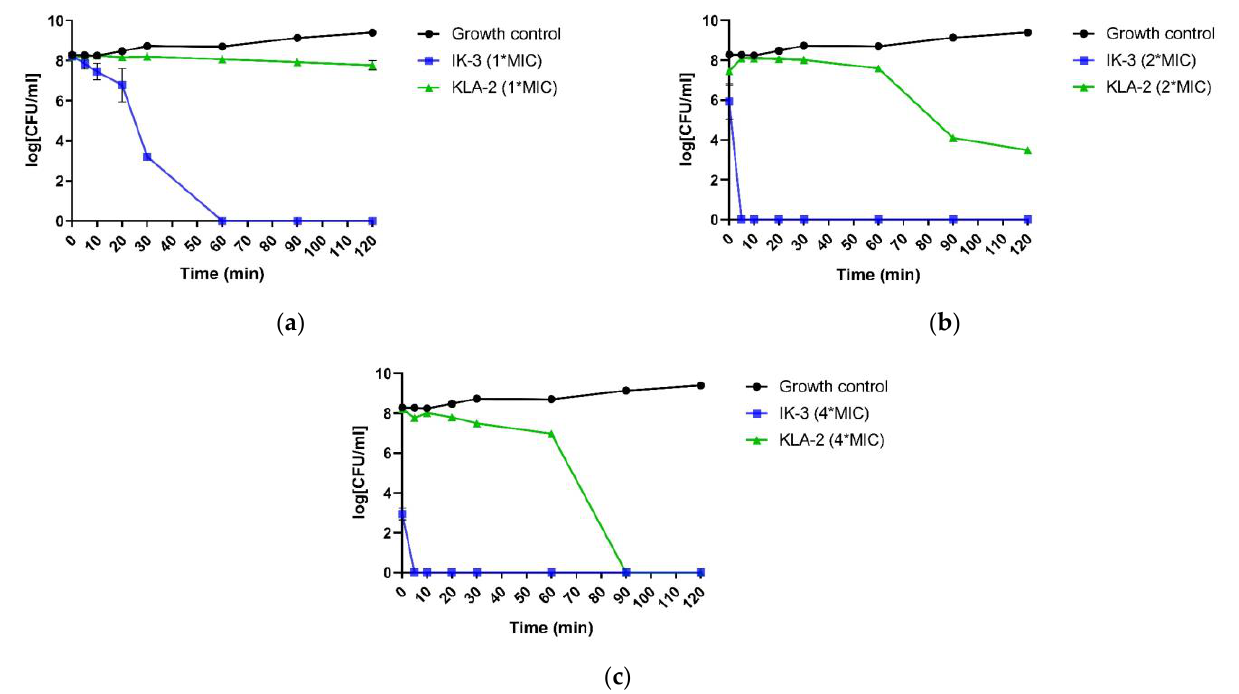
Figure 5. The kinetic killing curves of IK-3 and KLA-2 against E. coli (NCTC 8739) at ( a ) MIC, ( b ) 2-fold MIC, and ( c ) 4-fold MIC. The error bars in the graphs around mean data points indicate the standard error of the mean (SEM) for each set of data in the nine replicates from three experiments.